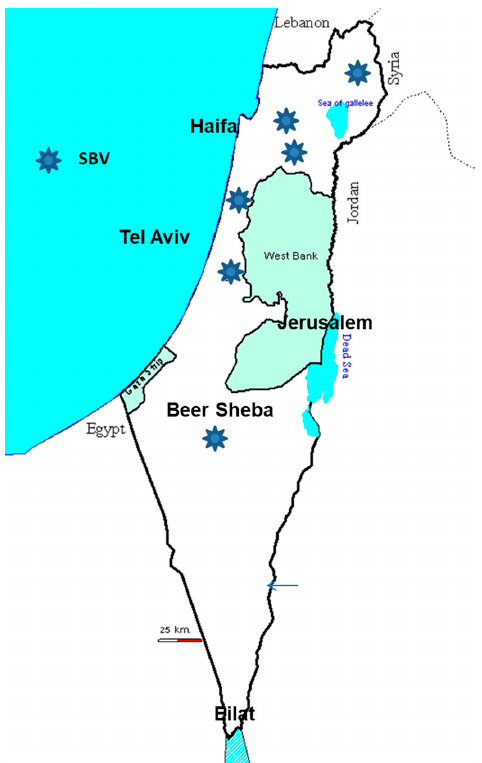
Figure 7. This figure shows the Schmallenberg virus (SBV) infected sites detected from 2018 to date. 8. Schmallenberg Virus Outbreak